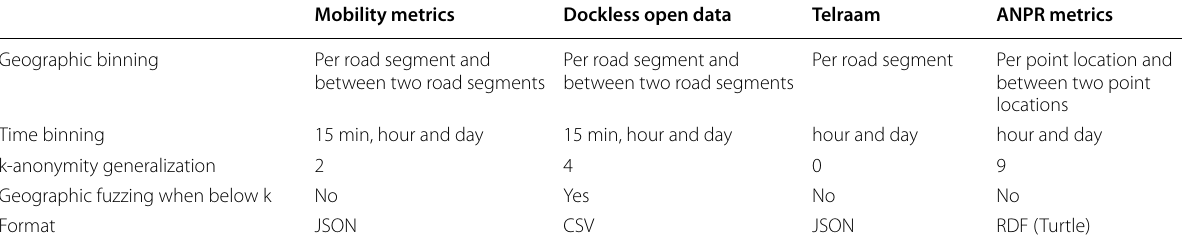
Table 2 Comparison of ANPR Metrics with the state of the art Mobility